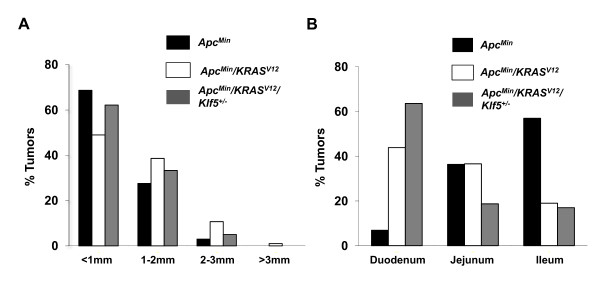
Assessment of intestinal tumor size and distribution in mutant mice. Percentages of intestinal tumors are displayed in bar graphs, with black bars representing ApcMin mice, white bars representing ApcMin/KRASV12 mice and gray bars indicating ApcMin/KRASV12/Klf5+/- mice. (A) Graph displaying tumor sizes in the small intestine. The tumors are sized based on 4 categories, <1 mm, 1-2 mm, 2-3 mm and >3 mm. Average percentages of tumors are represented on the Y-axis and tumor size categories on the X-axis; N = 8 and groups show a significant trend based on a one-way ANOVA test with P < 0.05. (B) Graph displaying tumor location in the small intestine. Tumor locations in the small intestine are divided into duodenum, jejunum and ileum. The graph is plotted with average percentage of tumors on the Y-axis and tumor locations on the X-axis; N = 8 and groups show a significant trend based on a one-way ANOVA test with P < 0.05.